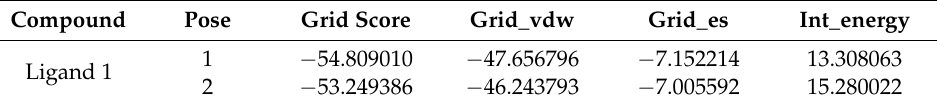
Table 6. Docking of ligand with receptor HDAC2 (unit: kcal/mol).